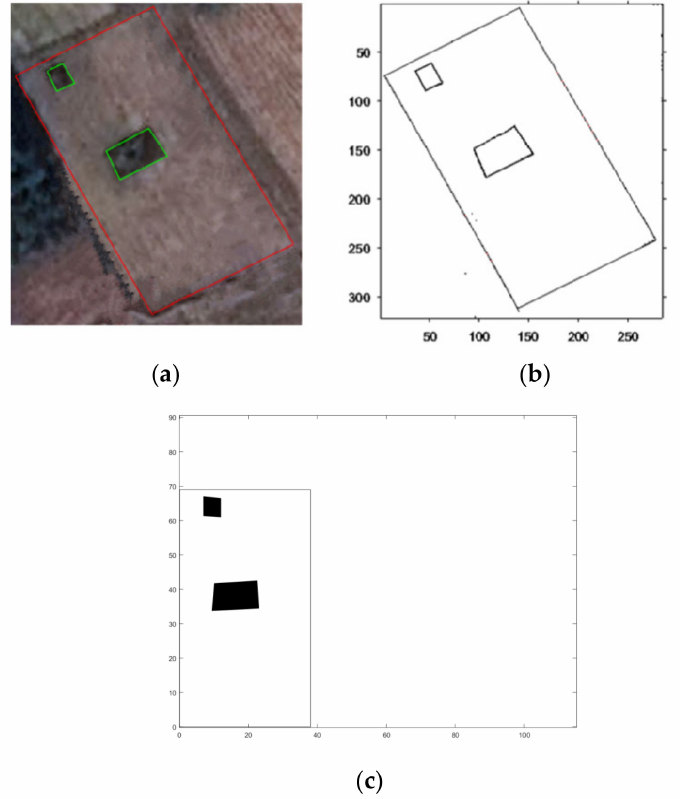
Figure 13. ( a ) Farmland map with obstacles; ( b ) map after binarization; ( c ) coordinate mapping to ( b ).